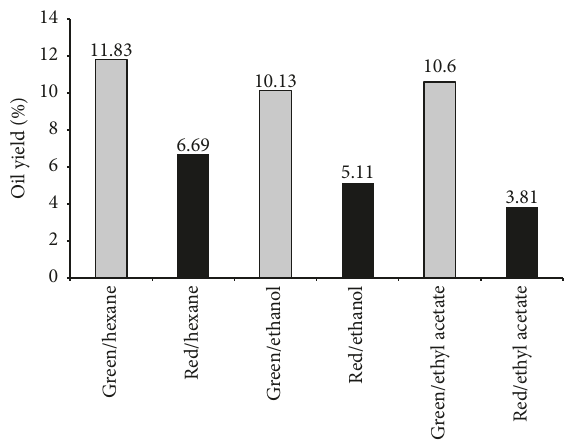
Figure 1: Oil yields (%) extracted from GCPS and RCPS with hexane, ethanol, and ethyl acetate.